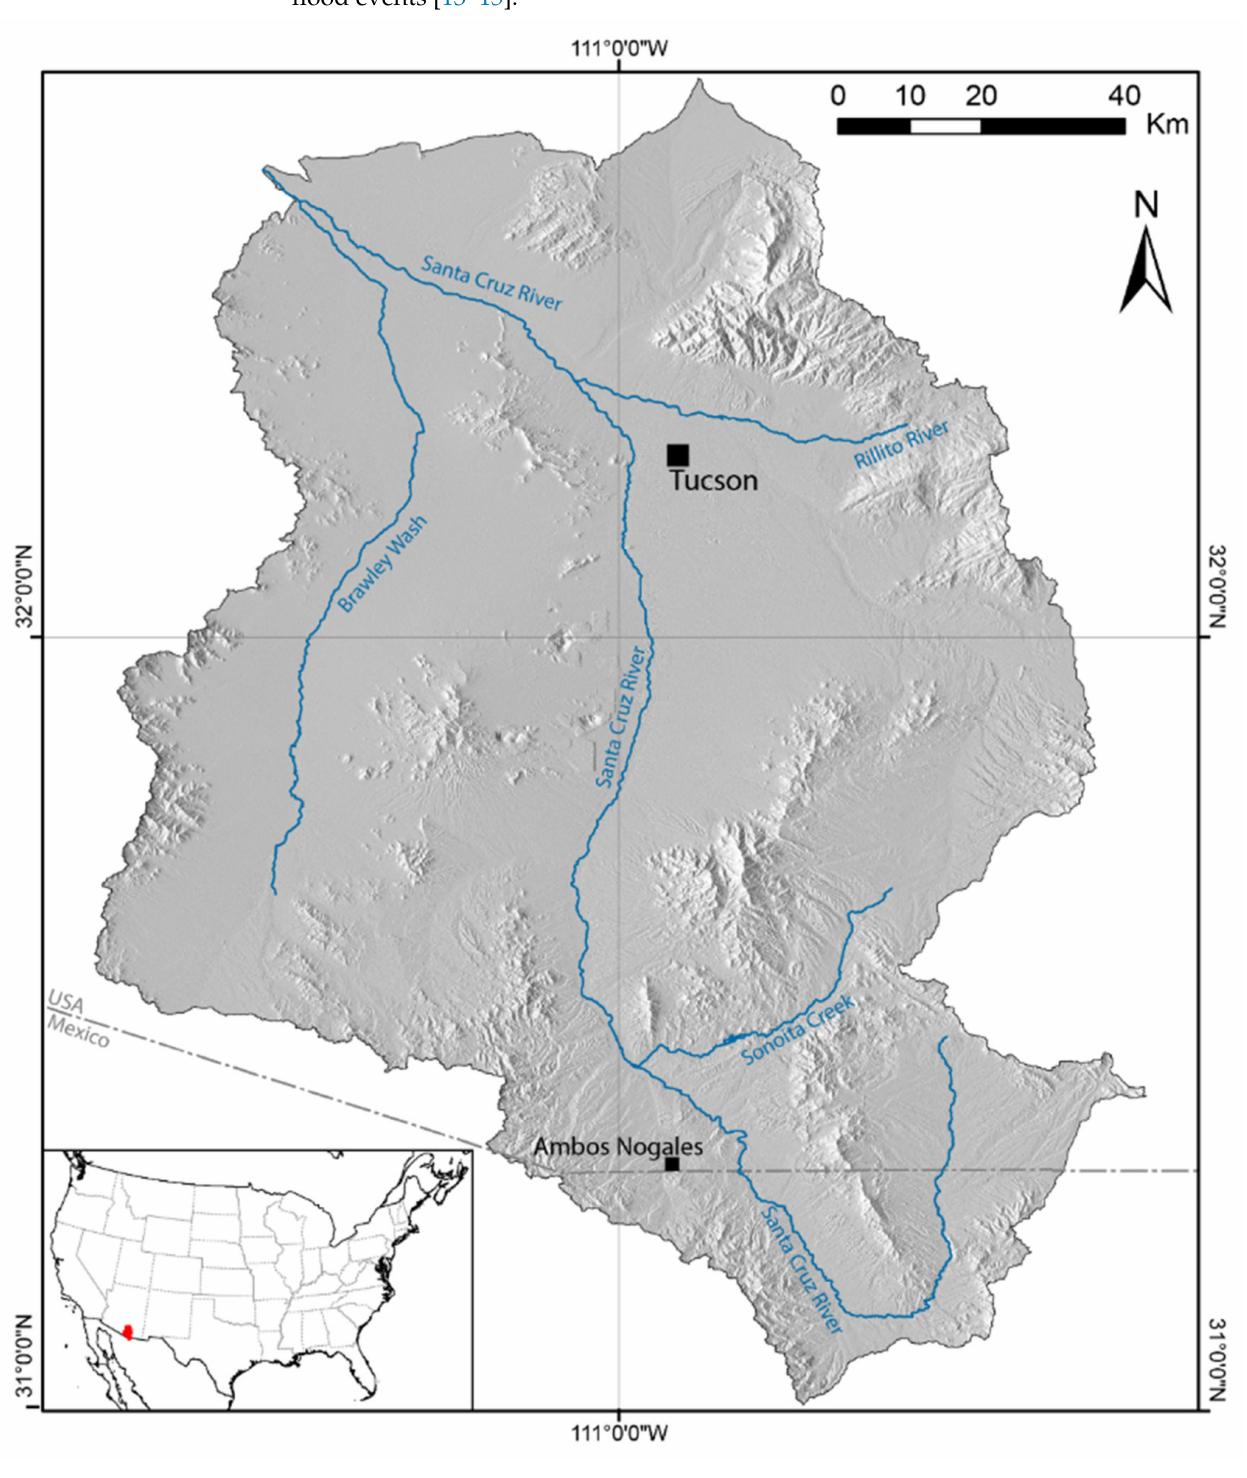
Figure 1. Study Area, Upper Santa Cruz Watershed. Hill shade base map derived from [43], streams and watershed boundaries from [44] and administrative division from